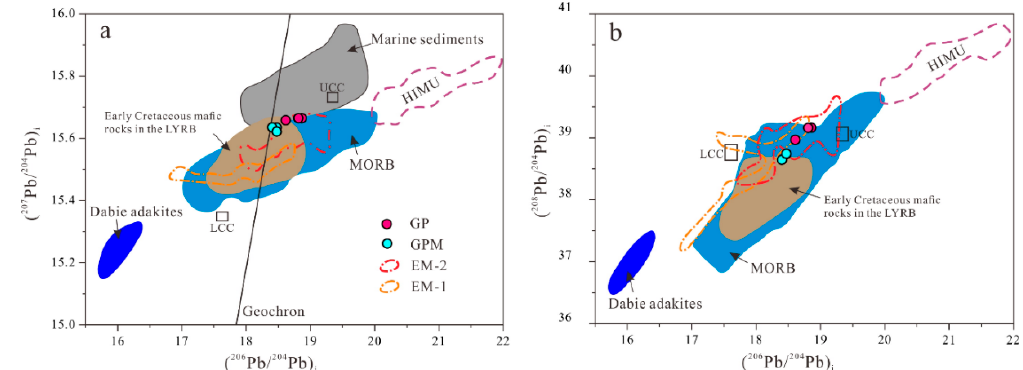
Figure 12. Initial Pb isotopes. ( a ) ( 207 Pb/ 204 Pb) i /( 206 Pb/ 204 Pb) i and ( b ) ( 208 Pb/ 204 Pb) i /( 206 Pb/ 204 Pb) i ) ratios of the Qiaomaishan intrusions. Data sources for MORB, Marine sediments, HIMU, EM-1, and EM-2 are from [45]; Early Cretaceous mafic rocks in the MLYRB are based on [16,34,37] and Dabie adakites